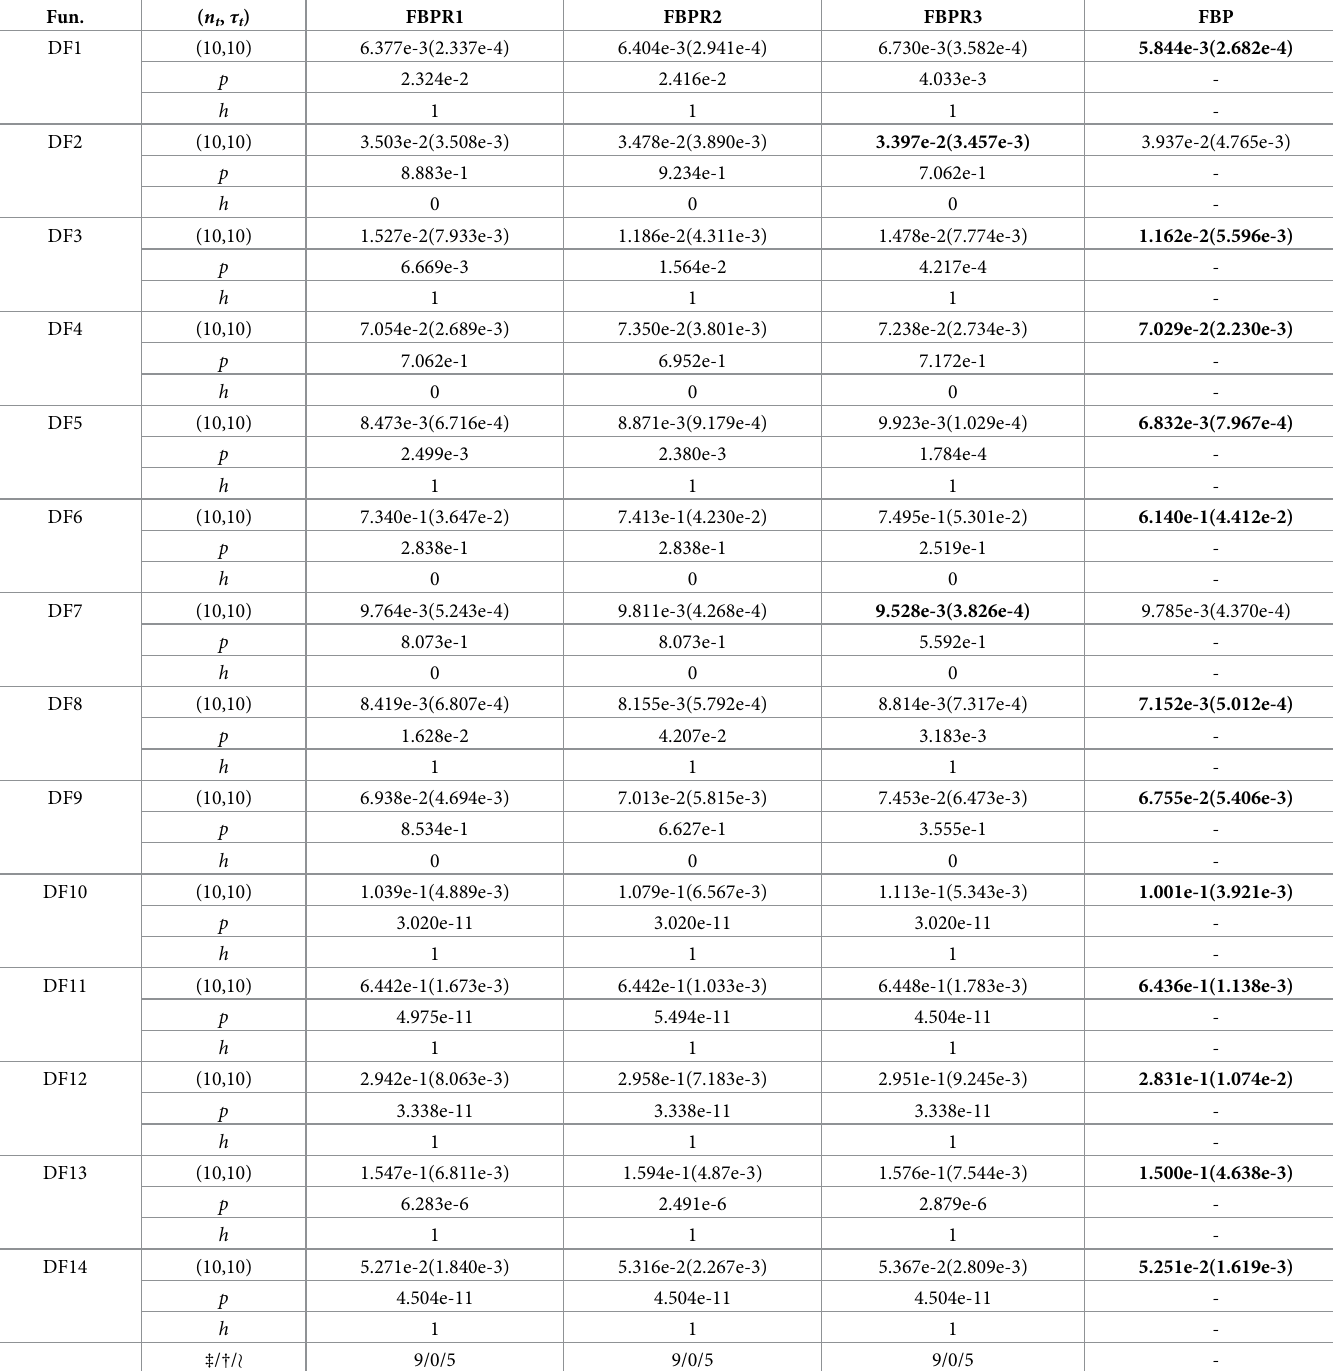
Table 16. Performance comparison of FBP variants on MIGD for ( n t , τ t ) = (10,10).